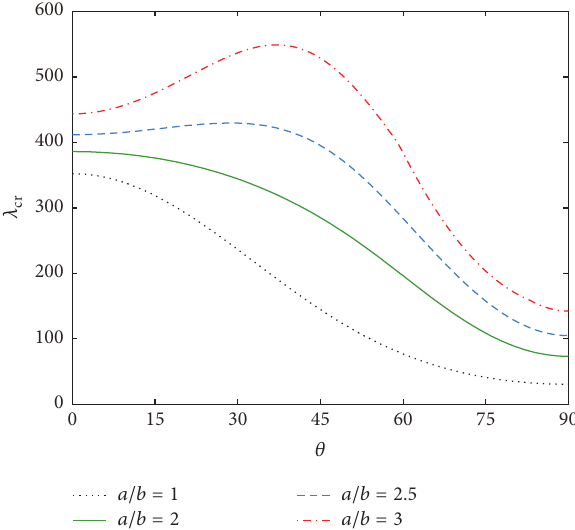
Figure 6: Flutter boundary versus layer angle with different length- to-width ratios.